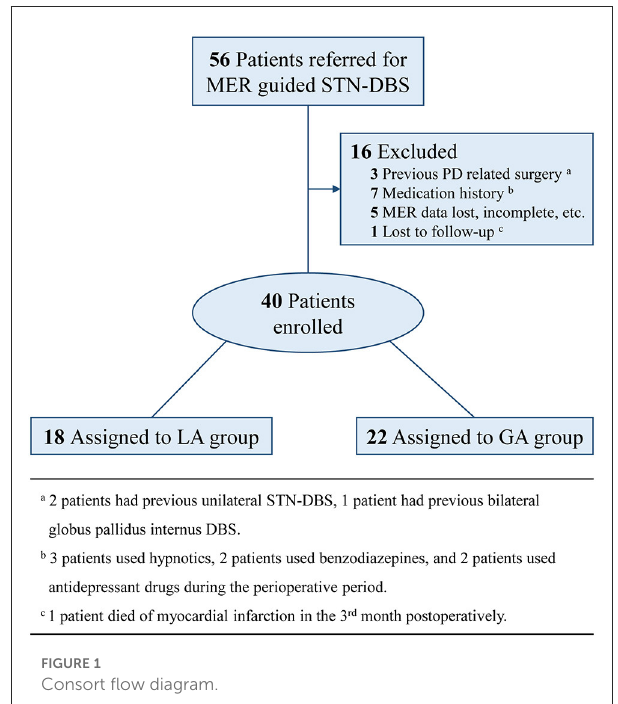
FIGURE1 Consort flow